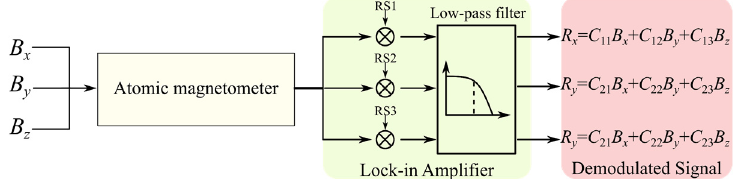
Figure 2. Schematic of the three-axis atomic magnetometer. R x , R y , and R z are the response signals and B x , B y , and B z are the magnetic fields to be measured. RS1, RS2, and RS3 are the reference signal with a frequency of ω x , ω y , and ω z ,